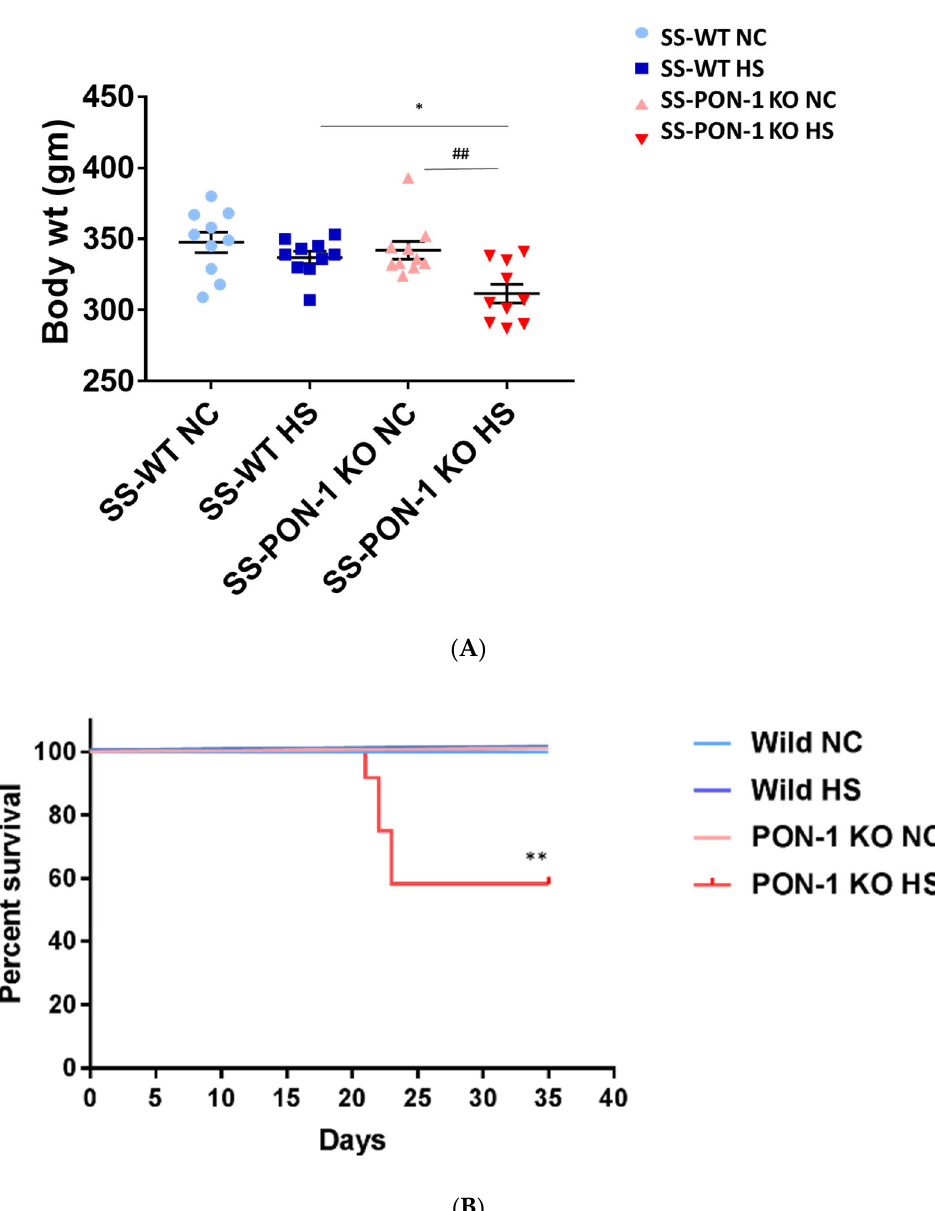
Figure 2. Targeted mutation of Paraoxonase ‐ 1 leads to phenotype changes and increased mortality. ( A ) phenotypic characteristics; SS ‐ PON ‐ 1 KO showed significant decrease in body weight compared to SS rats after 5 weeks on high ‐ salt diet (N = 10). ( B ) Early mortality observed in SS ‐ PON ‐ 1 KO rat models after average of 33 days of high ‐ salt diet (8% NaCl), while no mortality was observed in SS rats (N = 12). * p < 0.05, ** p < 0.01 vs. high ‐ salt, ## p < 0.01 vs. normal chow.